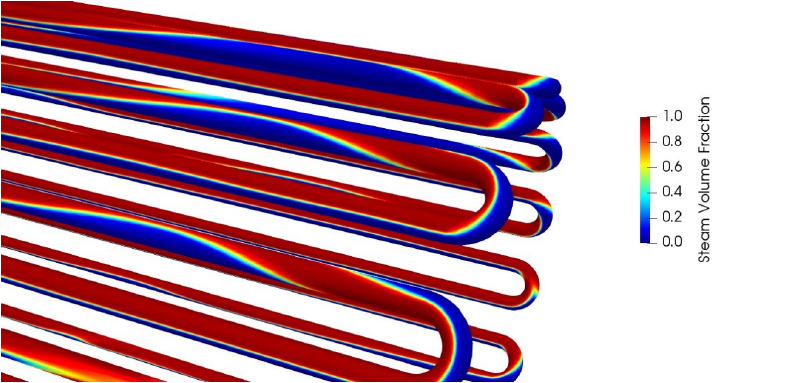
Figure 26. Vapor phase fraction contour within the radiant